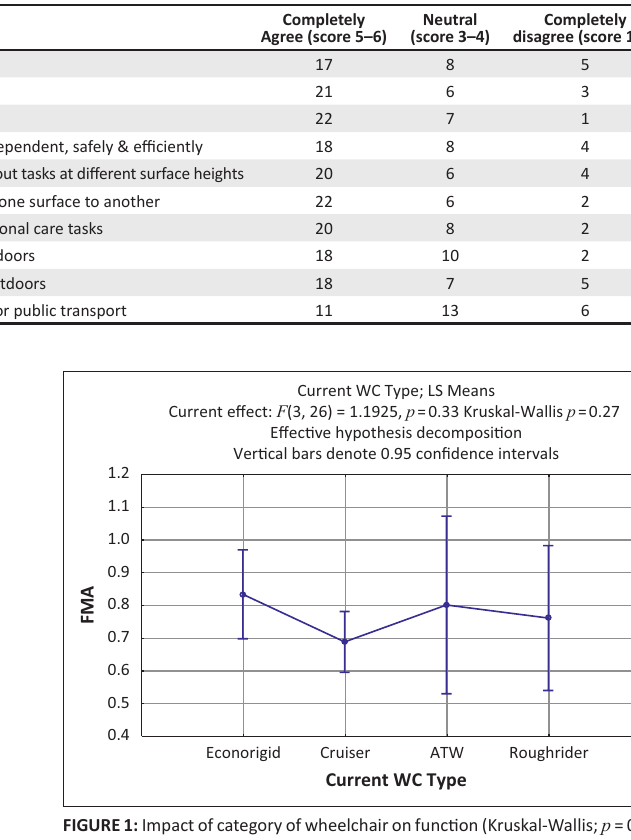
TABLE 3: Ability to perform functional tasks in the wheelchair according to FMA scores. Variable